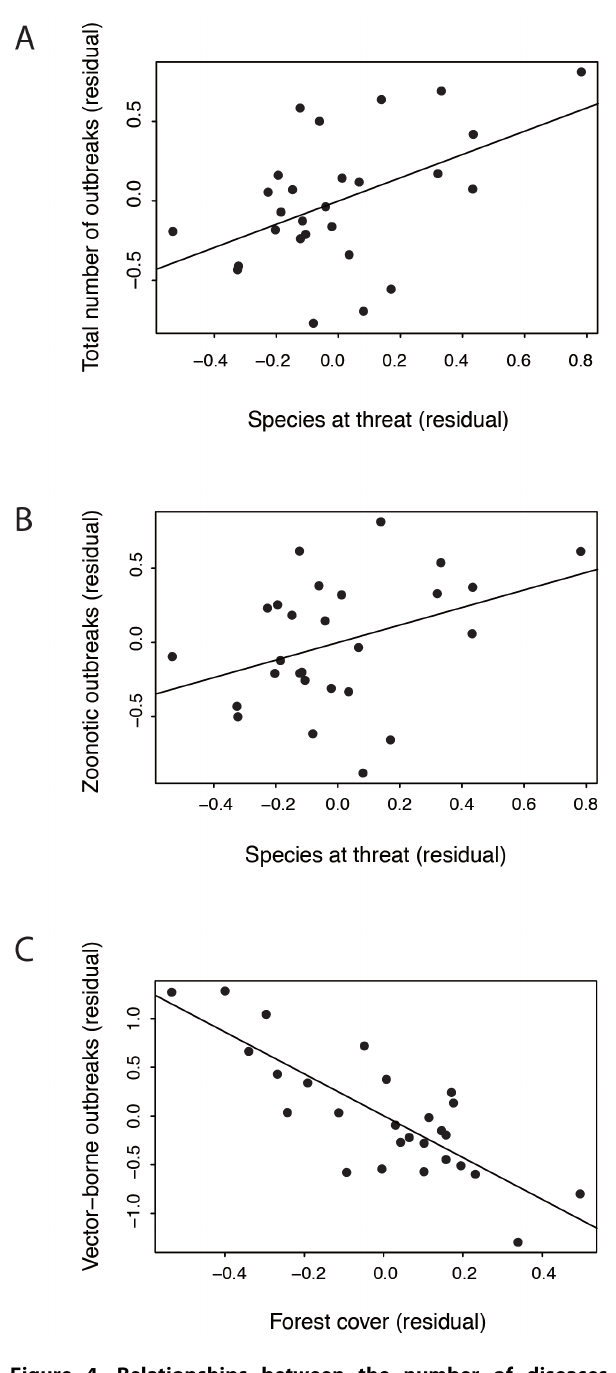
Figure 4. Relationships between the number of diseases causing outbreaks and biodiversity indices in Asia-Pacific countries (partial correlations of the best GLM selected in Table 2). A. Total number of infectious diseases with outbreaks and number of threatened vertebrate species. B. Total zoonotic diseases with outbreaks and number of threatened vertebrate species. C. Total number of vector-borne diseases with outbreaks and forest cover.